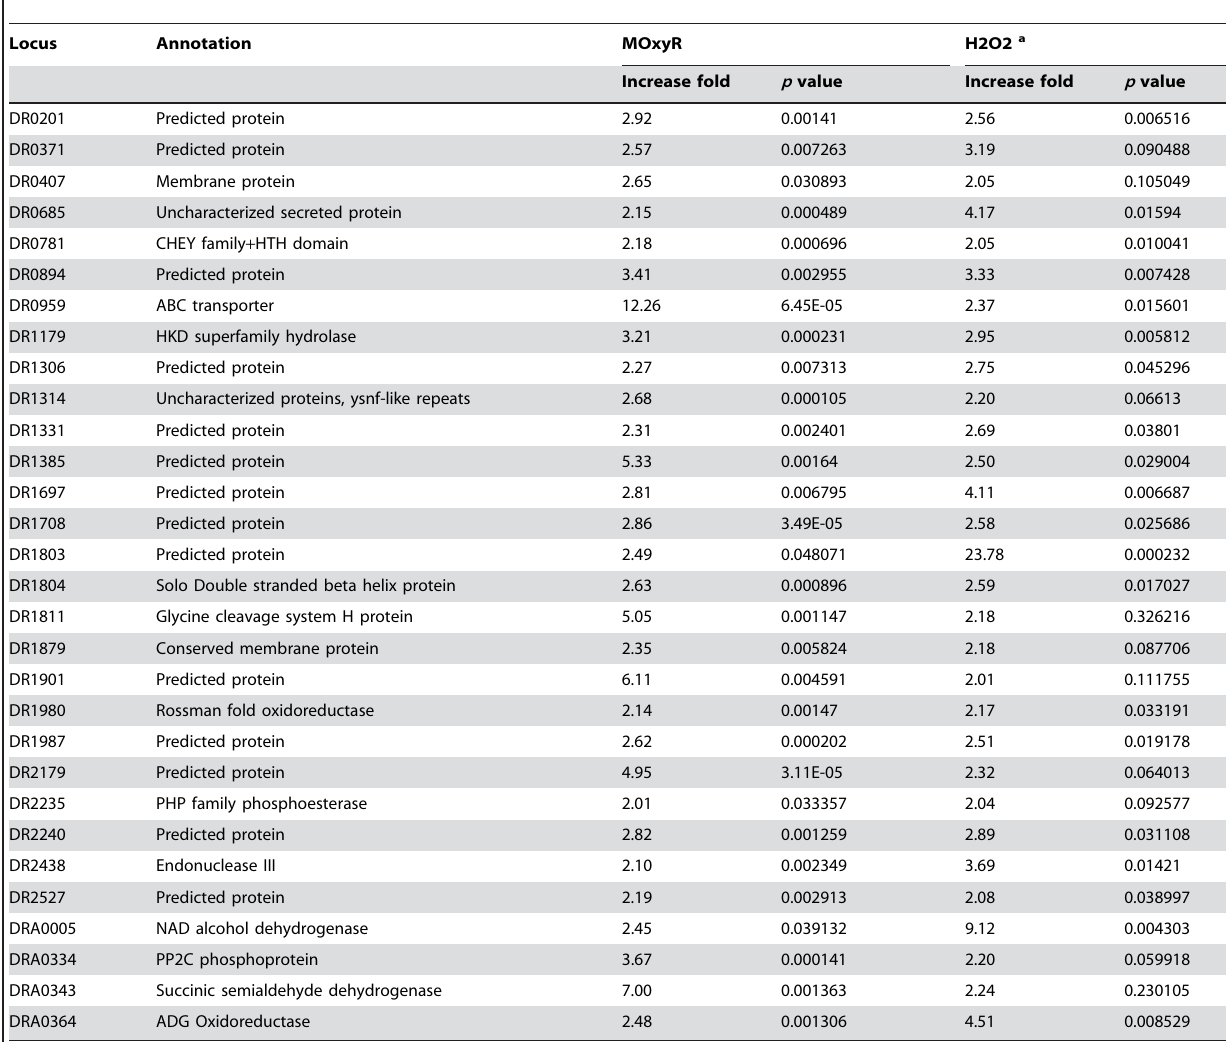
Table 7. Genes with an increased level of expression both in wild-type strains treated with H 2 O 2 (20 mM) an in MOxyR.